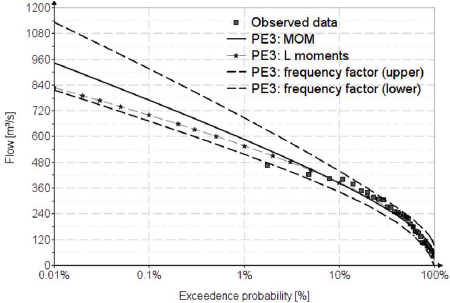
Figure 3. Pearson III distribution.